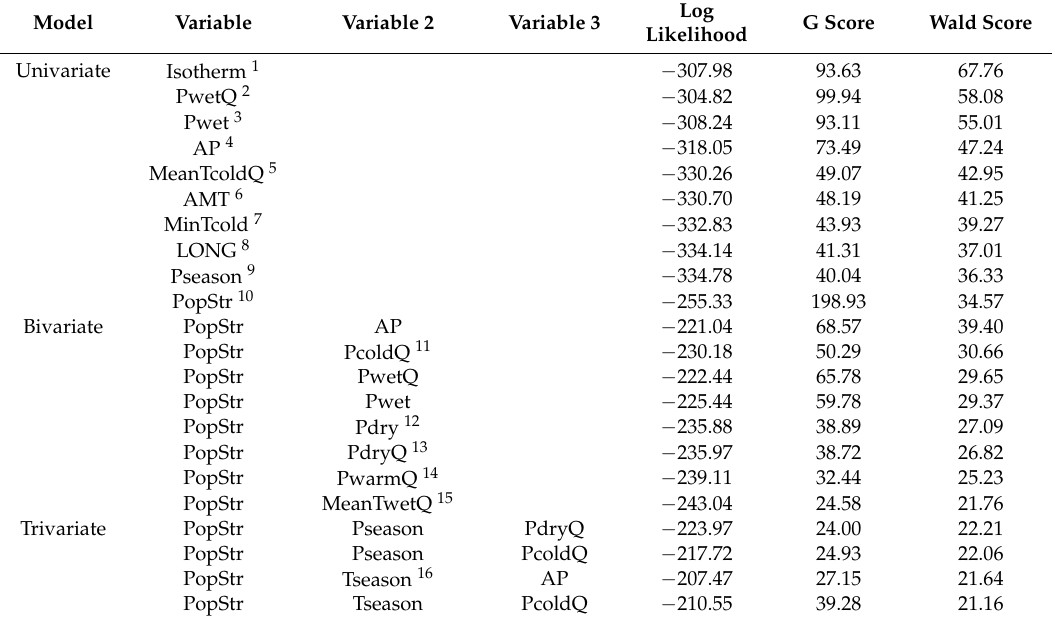
Table 1. Results of spatial analysis of correlation between the β 52Cys allele frequency, population structure and environmental variables for continental Europe, using the Sam β ada program and showing the 10 best univariate models according to the Wald score and the multivariate models containing population structure; α = 0.01. Population structure was represented by the probability of belonging to the Western lineage (essentially zero or one). A set of 19 temperature and rainfall variables (Bioclim dataset available in the WorldClim database) was used as the environmental